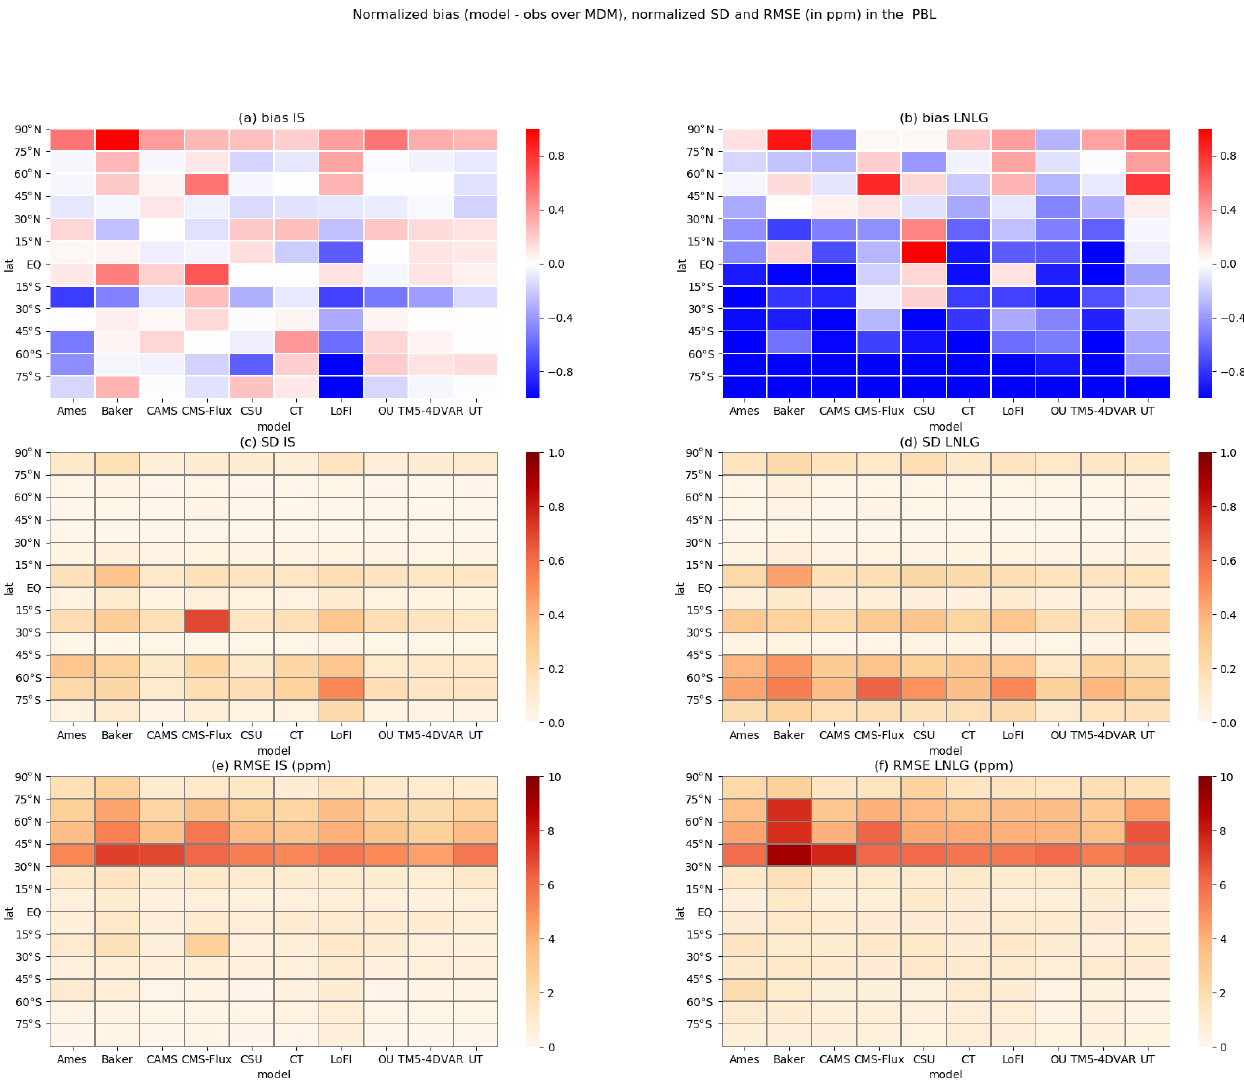
Figure 14. Normalized bias (a, b) , normalized standard deviation (c, d) , and root-mean-square error (RMSE in ppm; e, f ) by latitudes for each model and for the IS experiment (a, c, e) and the LNLGv9 experiment (b, d, f)